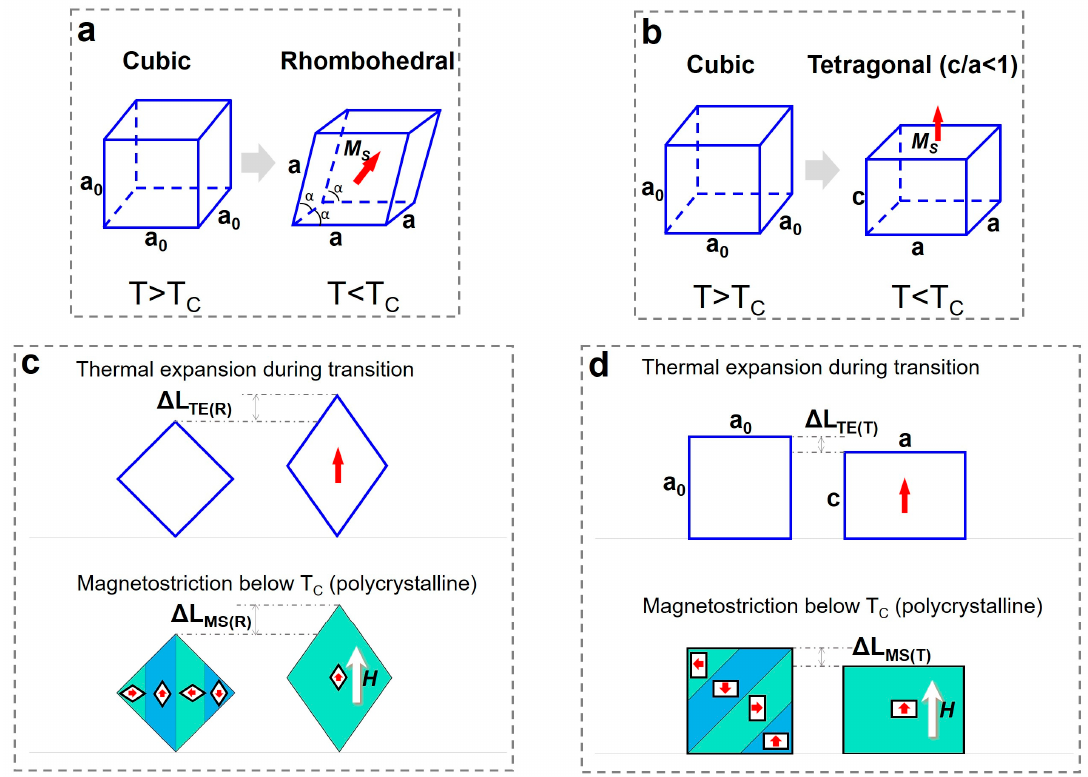
Figure 1. (Color online) Schematic illustrations of structural transition involved in paramagnetic ( C )–ferrimagnetic ( R ) transition ( a ) and paramagnetic ( C )–ferrimagnetic ( T ) transition ( b ); ( c ) shows the thermal expansion and magnetostriction for paramagnetic ( C )–ferrimagnetic ( R ) transition and ( d ) shows the thermal expansion and magnetostriction for paramagnetic ( C )–ferrimagnetic ( T ) transition.